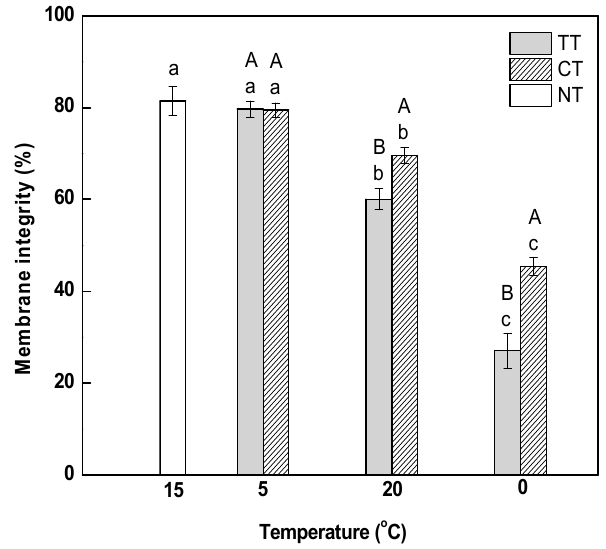
Figure 1. Effect of calcium on cytomembrane integrity in M. baccata leaves under temperature stress. TT , temperature treatment; CT , calcium treatment; NT , control. Lowercase letters above the bars indicate significant difference at p < 0.05 (Duncan’s test) of different treatments at the same temperature. Capital letters above the bars indicate significant difference at p < 0.05 (Duncan’s test) of the same treatment at different temperature.